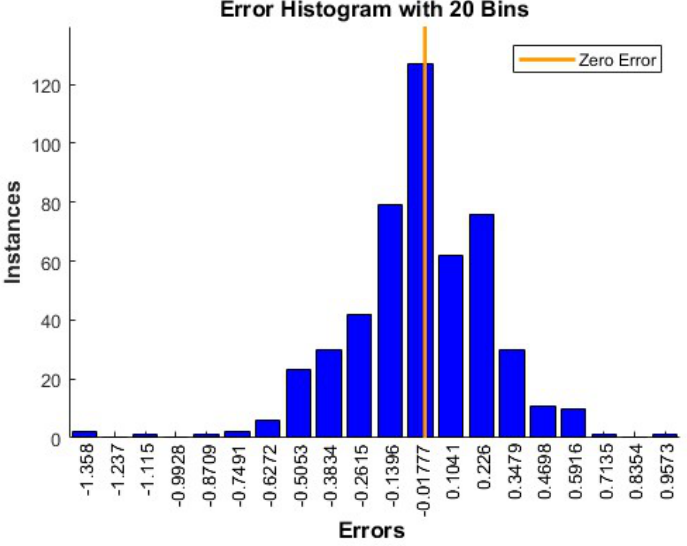
Figure 5. The results of absolute error for the temperature values determined using the MLP 4-7-1 model in relation to the testing file.